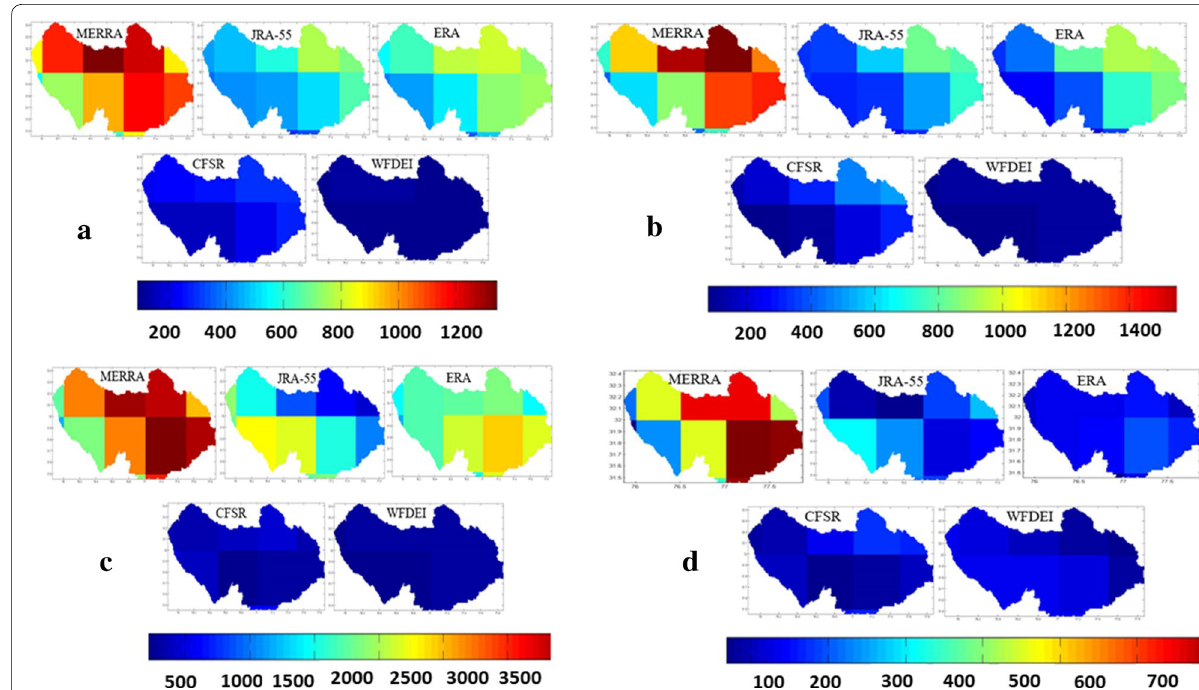
Fig. 2 Spatial variation of gridded Precipitation during ( a ) Winter (December-February), ( b ) Summer (March–May), ( c ) Monsoon (June–August) and ( d ) post-Monsoon